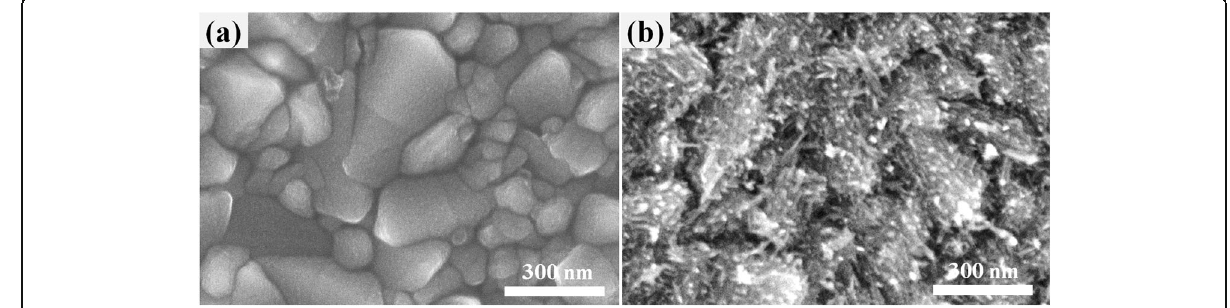
Fig. 2 Top-view SEM images of a TiO 2 /FTO and b 2% Nb:TiO 2